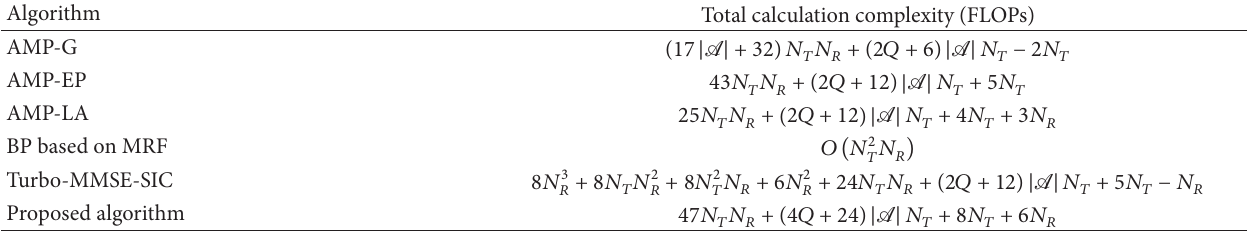
Table 1: Computational complexity comparison for subcarrier per iteration.